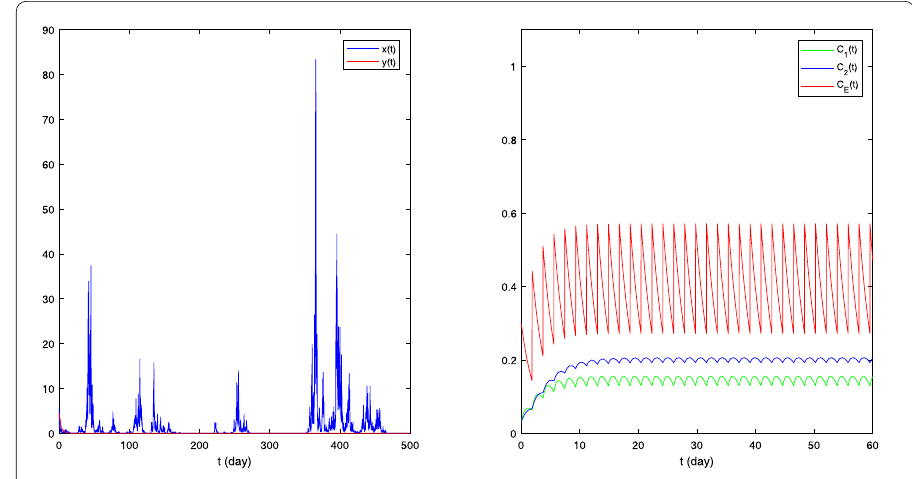
Figure 3 The sample paths of stochastic model (5.1) with π = (0.9,0.1), a 1 = (0.62,0.8), b 1 = (0.021,0.04), α = 0.2, β = 0.1, r 1 = 0.9, σ 1 = 1, a 2 = (0.2,0.4), b 2 = 0.04, k = 0.2, r 2 = 0.8, σ 2 = 0.2, ρ = 1.86, x 0 = 5, y 0 = 4